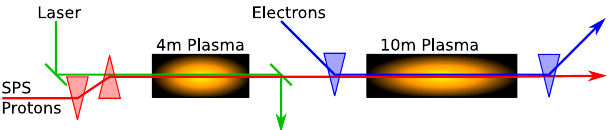
FIG. 1. A simplified illustration of the experimental setup for AWAKE Run 2. The SPS proton beam undergoes self- modulation in the first plasma section. The electron witness beam is injected into the accelerating structure, and undergoes acceleration in the second plasma section